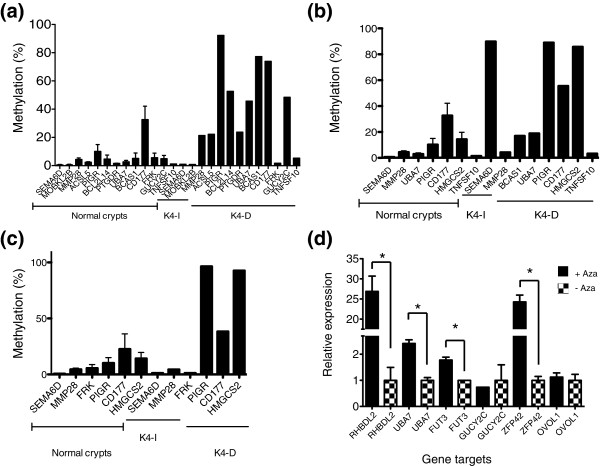
K4-dependent promoters are DNA hypermethylated. (a-c) Percentage DNA methylation of indicated K4-dependent (K4-D) and K4-independent (K4-I) genes in SW480 (a), V432 (b), and V441 (c). For comparison, methylation levels of genes were also quantified in normal colon crypts. Error bars indicate the standard deviation of pyrosequencing assays performed on three independent preparations of normal colon crypts. All K4-independent genes analyzed contain a CpG island at the TSS. All K4-dependent genes, except PTGDR, lack a CpG island at the TSS. (d) Quantitative RT-PCR analyses of genes from 5-azacytidine (Aza) treated (+) and untreated (-) SW480 cells. Data were normalized to GAPDH. RHBDL2, UBA7, FUT3, and GUCY2C are K4-dependent genes that lack a CpG island. ZFP42 was previously found in this cell line to be DNA hypermethylated and reversible upon treatment with 5-azacytidine, and thus serves as a positive control. OVOL1 is a K4-independent gene with a promoter-associated CpG island and serves as a negative control. Error bars indicate the standard deviation of quantitative RT-PCR reactions performed in triplicate. *P ≤ 0.01.